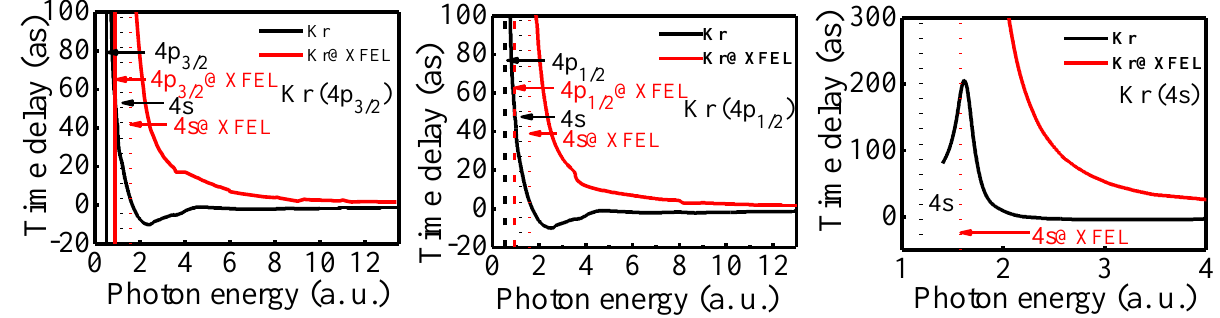
Figure 13. Time delay (τ) of 4p 3/2 (Left), 4p 1/2 (Middle), and 4s (Right) subshells of Kr (black) and Kr@XFEL (red). Solid, dashed, and dotted vertical lines represent the threshold for 4p 3/2 , 4p 1/2 , and 4s thresholds of free (black) and confined atom (red) respectively.